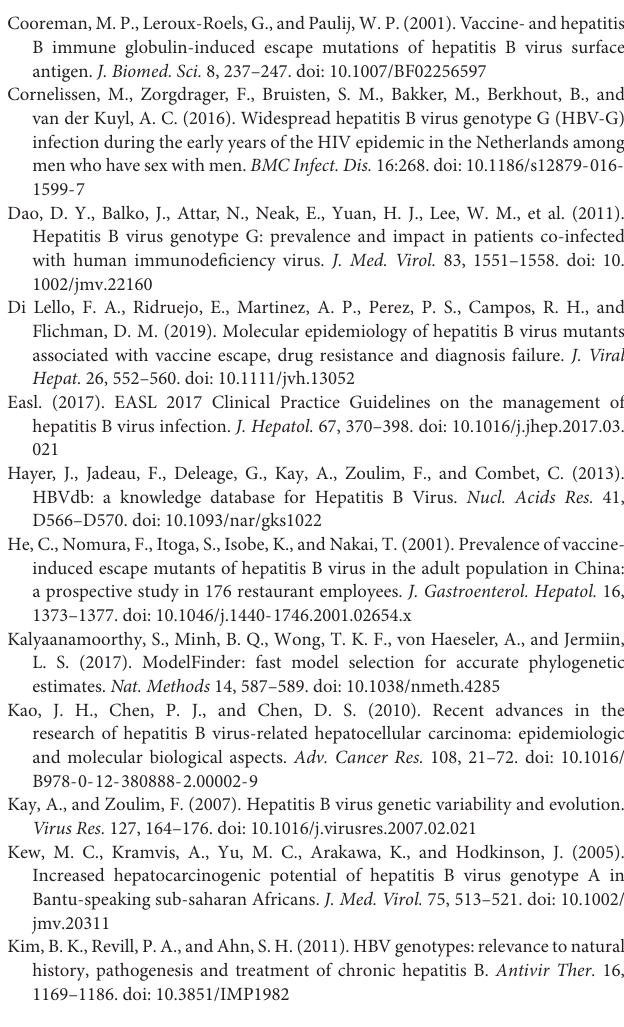
Supplementary Table 1 | HBV complete genome sequences dataset. Supplementary Table 2 | Clinically relevant HBV mutants by (sub)genotype and geographic